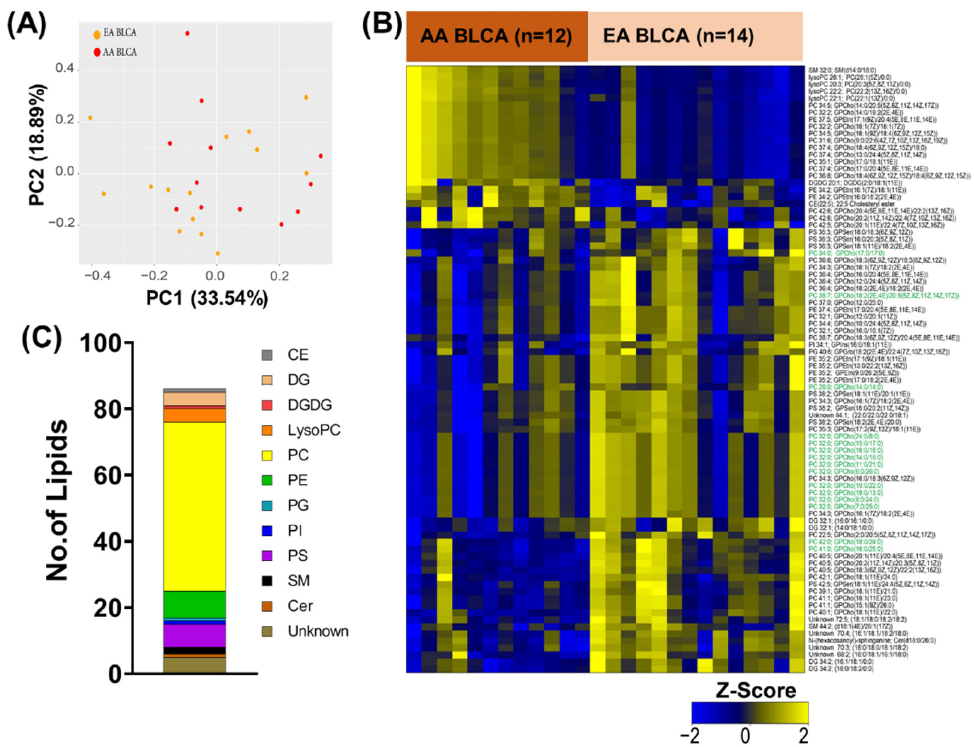
Figure 1. Altered lipidome in ethnicity balanced AA BLCA vs. EA BLCA from AU cohort. ( A ) PCA plot using lipid profiles in AA BLCA (n = 12), EA BLCA (n = 14) tissues. ( B ) Heat map showing significantly (FDR < 0.25) altered lipids in AA BLCA (n = 12) vs. EA BLCA (n = 14) tissues. Shades of yellow and blue represent up ‐ and down ‐ regulated lipids, respectively (z ‐ score) (Note: Saturated PCs are highlighted in green). ( C ) Altered lipids from panel B are arranged by class, Cholesterol esters (CEs), Diglycerides (DGs), Lysophosphatidylcholine (Lyso PCs), Phosphatidylcholines (PCs), Phosphatidyl ethanolamines (PEs), Phosphatidylglycerols (PGs), Phosphatidylinositols (PIs), Phosphatidyl Serines (PSs), Sphingomyelins (SMs), Ceramides (Cers), and Unknown lipids.